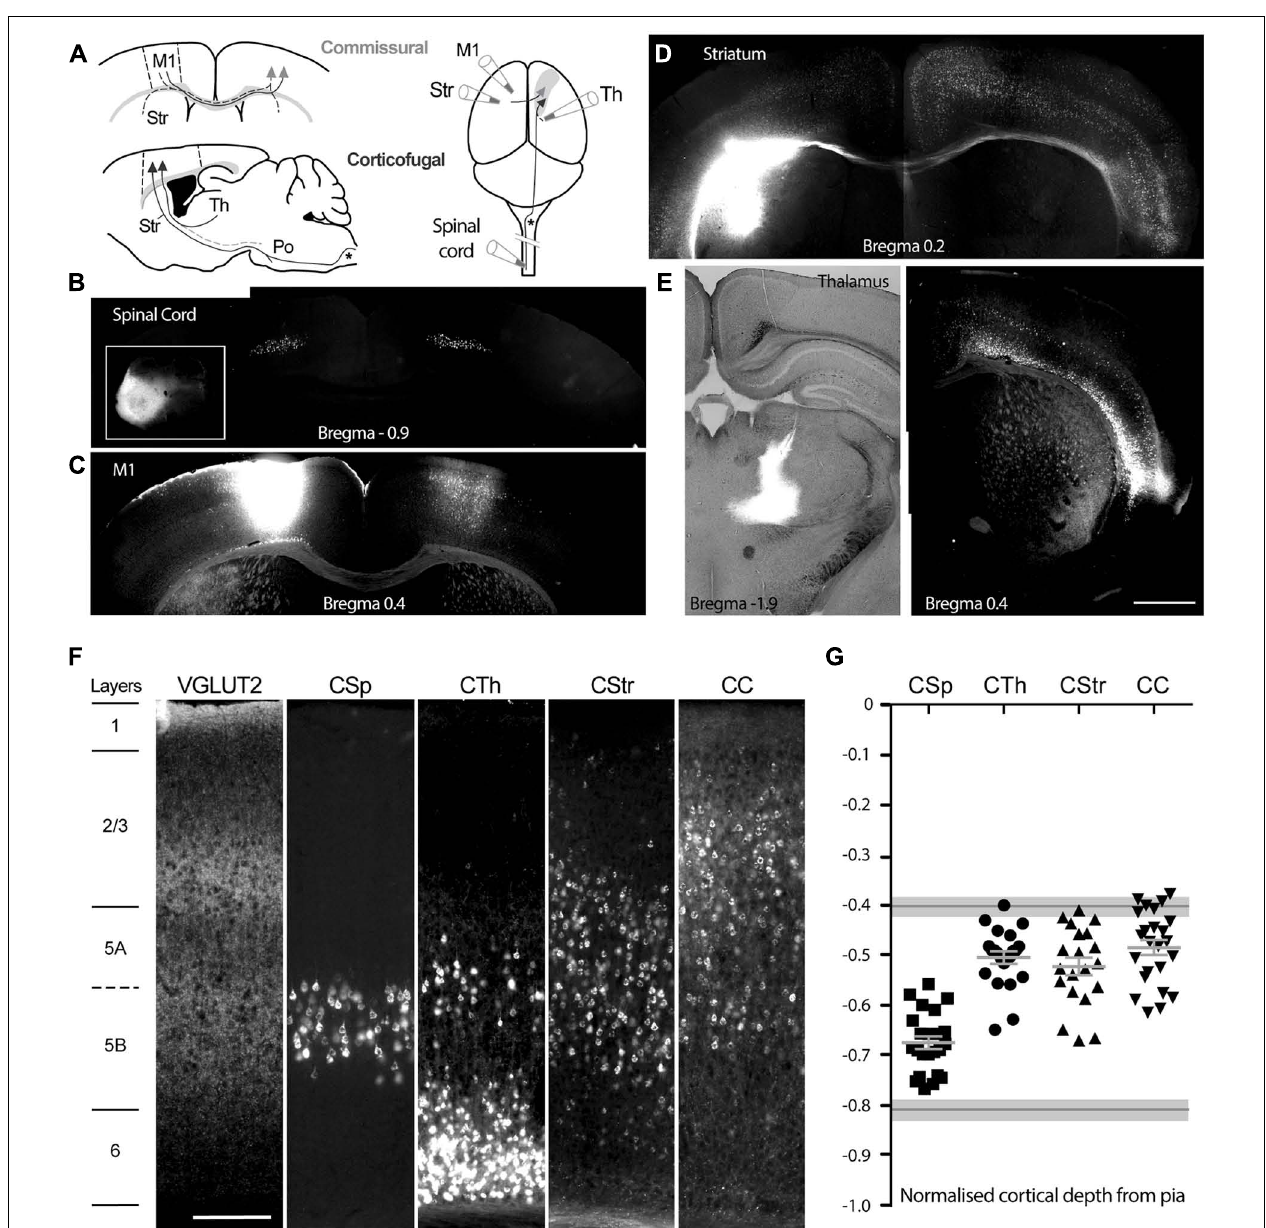
FIGURE 1 | Injection sites and profiles of retrogradely labeled neurons in mouse primary motor cortex, M1. (A) Schematic of retrograde tracer injection sites targeting either commissural neurons projecting through the corpus callosum across hemispheres, or corticofugal neurons projecting ipsilaterally to the thalamus, brainstem, and spinal cord. M1 (borders delineated by the dashed lines) denotes the site for labeling of corticocortical neurons CC, in the contralateral hemisphere, see arrow heads; Str denotes the site for labeling of corticostriatal, CStr, neurons, these neurons also send collaterals across the midline to the contralateral cortex, dashed line with arrowheads. Spinal cord and Th denote sites for labeling of corticospinal, CSp and corticothalamic, CTh neurons respectively. Note that the corticospinal tract decussates in the medulla oblongata (shown by an asterisk *) and that axons projecting from the thalamus to M1 may be collaterals of neurons that project to the brainstem, e.g., pontine nuclei, Po, as shown by the dashed line, lower panel (A) . (B) Bilateral labeling of corticospinal neurons in M1 and S1 hindlimb regions